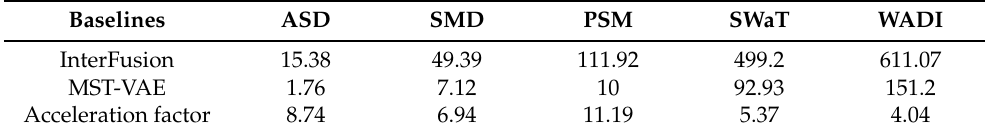
Table 4. Training time (second) per epoch on each